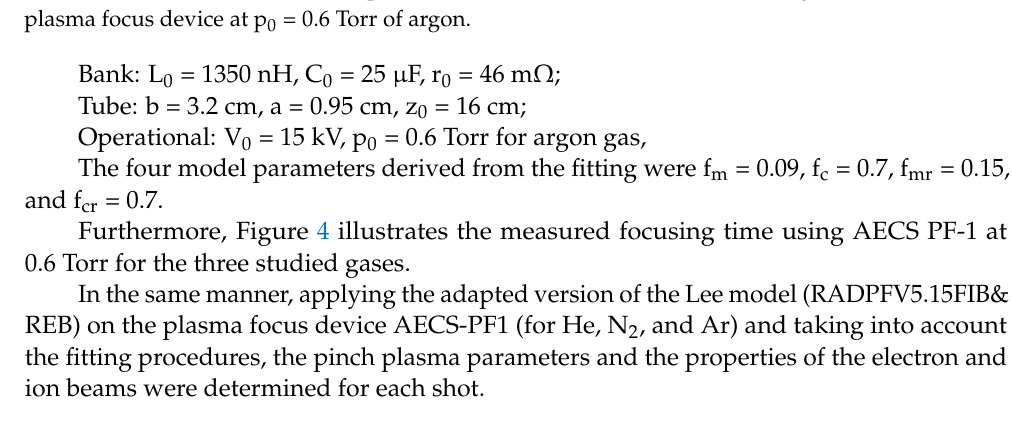
plasma focus device at p 0 = 0.6 Torr of argon.